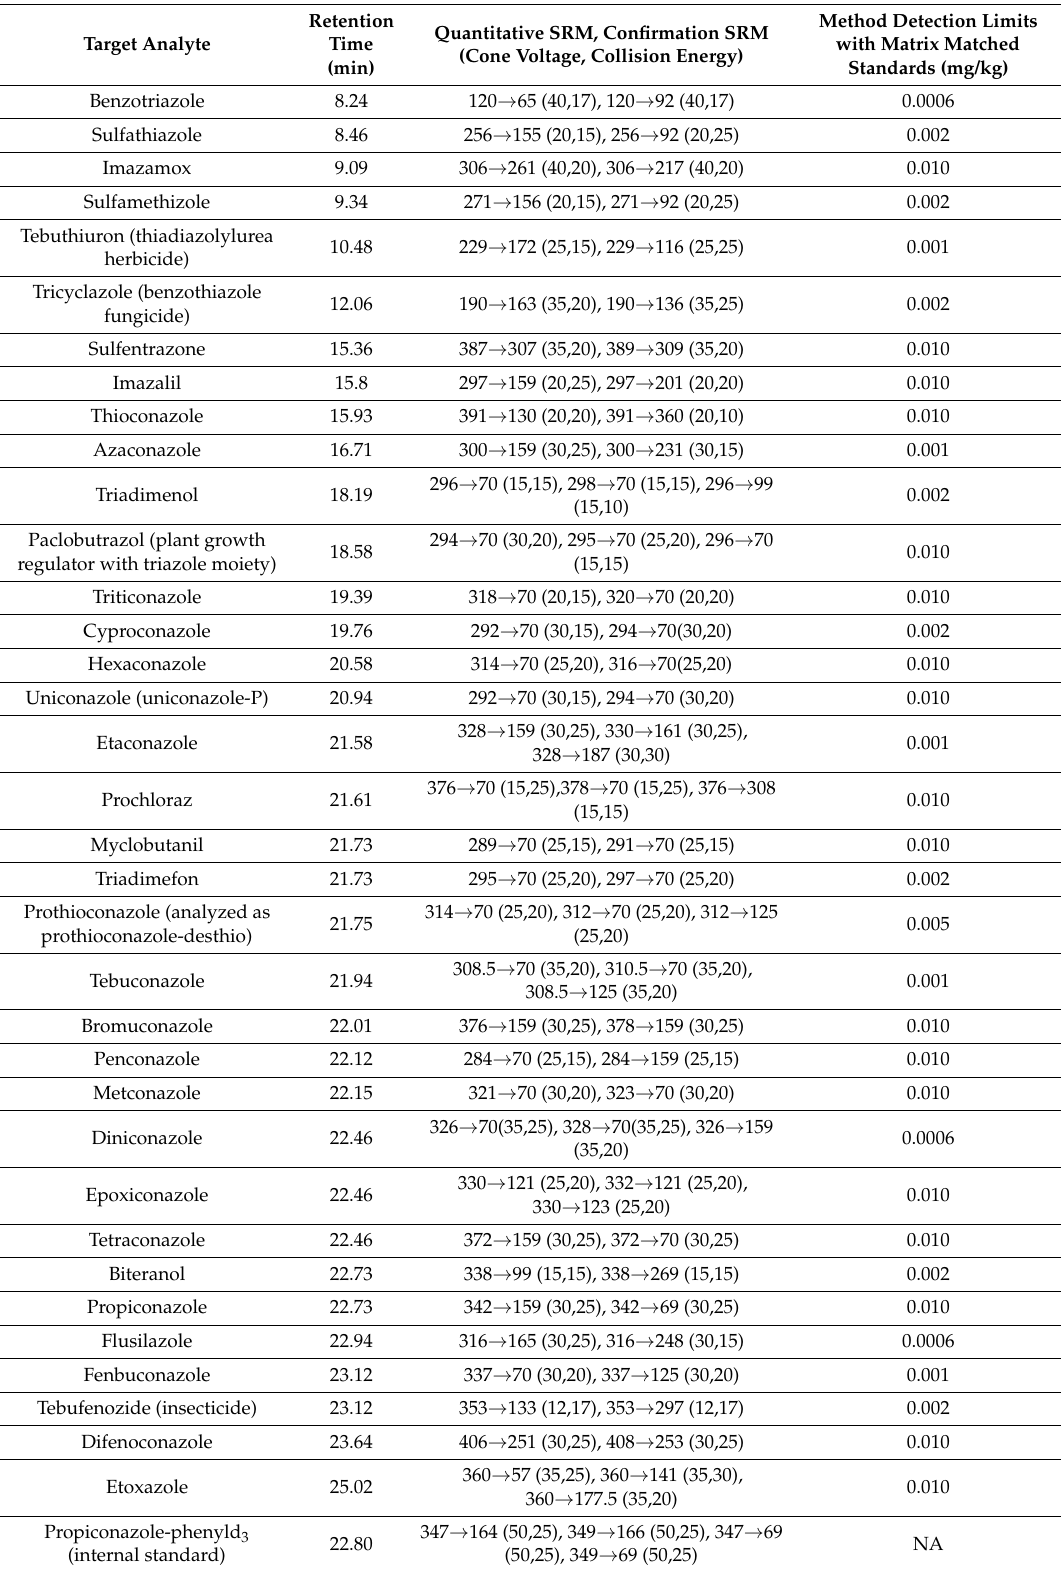
Table 1. Selected Reaction Monitoring Transitions (SRMs) for Target Analytes Analyzed by LC-ESI +